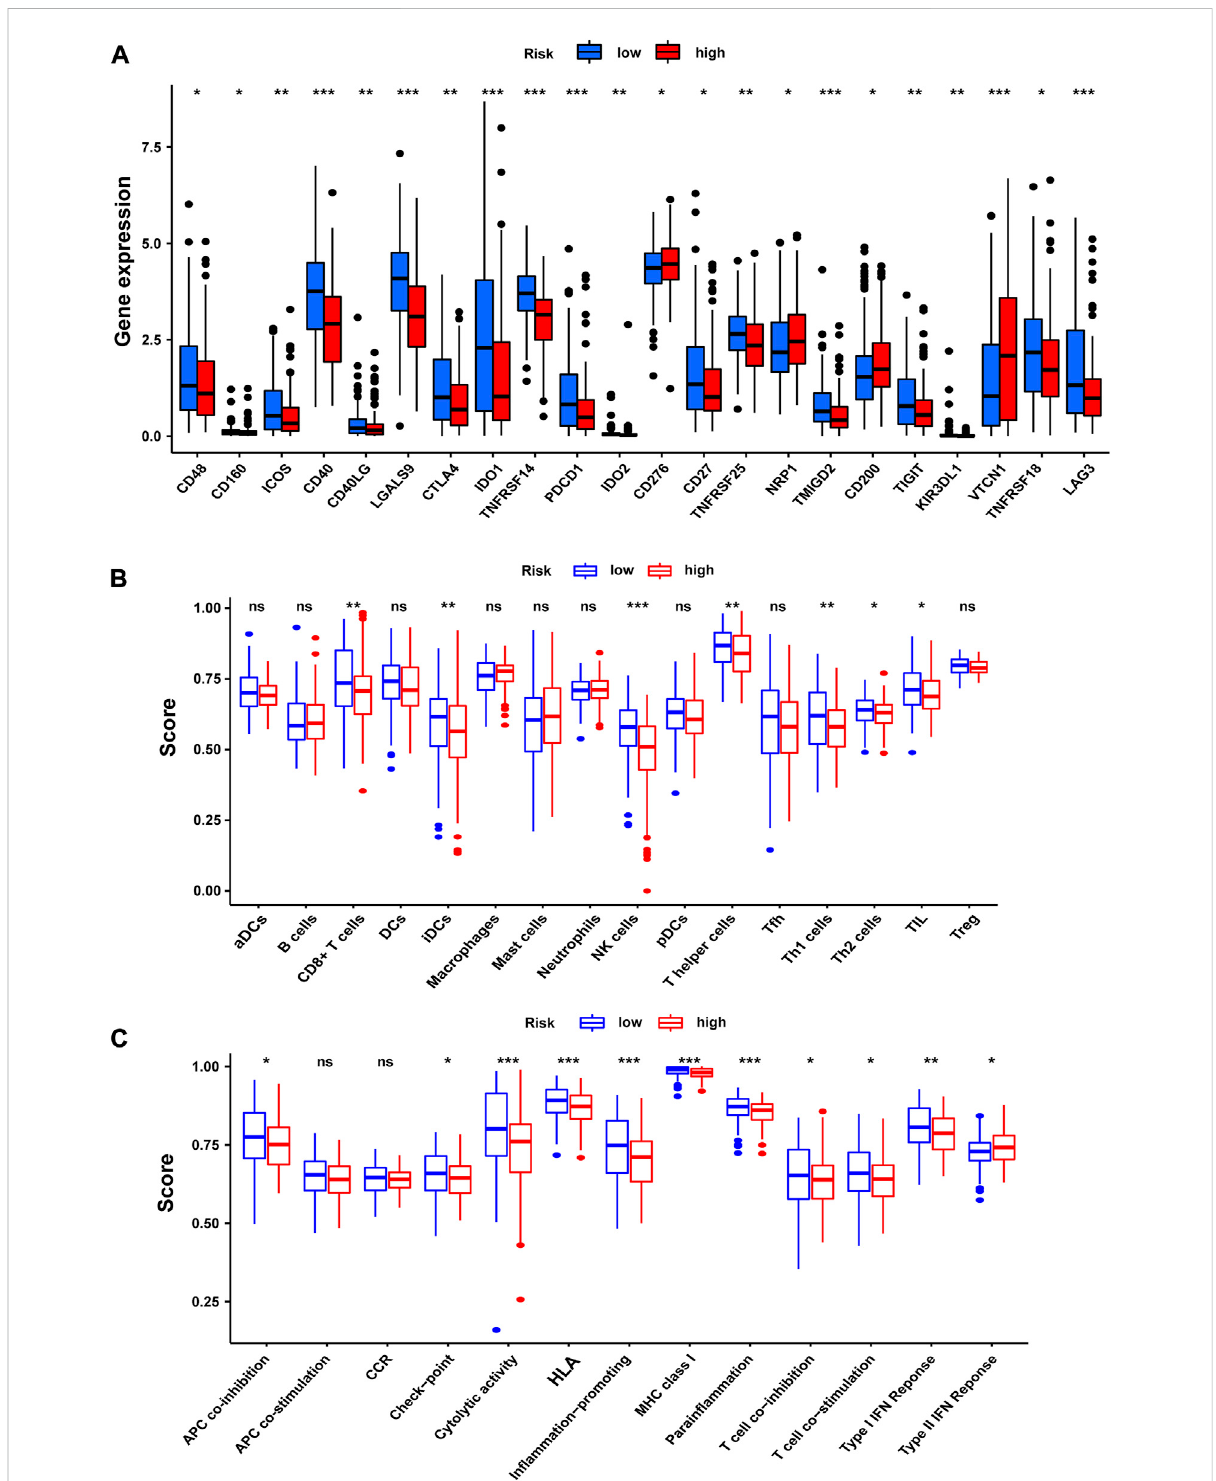
FIGURE 11 Tumor immune microenvironment of the NRG score. (A) Expression of immune checkpoints among high- and low-risk groups. (B) In fi ltration of22TIICsinhigh-andlow-riskgroups. (C) Immune-relatedfunctionsintheNRGscore-de fi nedgroups.* p < 0.05;** p < 0.01;*** p < 0.001;ns=not signi fi